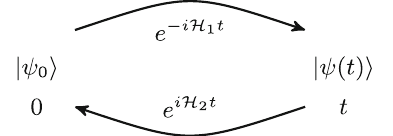
Fig. 1 LE as an echo quantity measures how much a quantum state is recovered by an imperfect time reversal